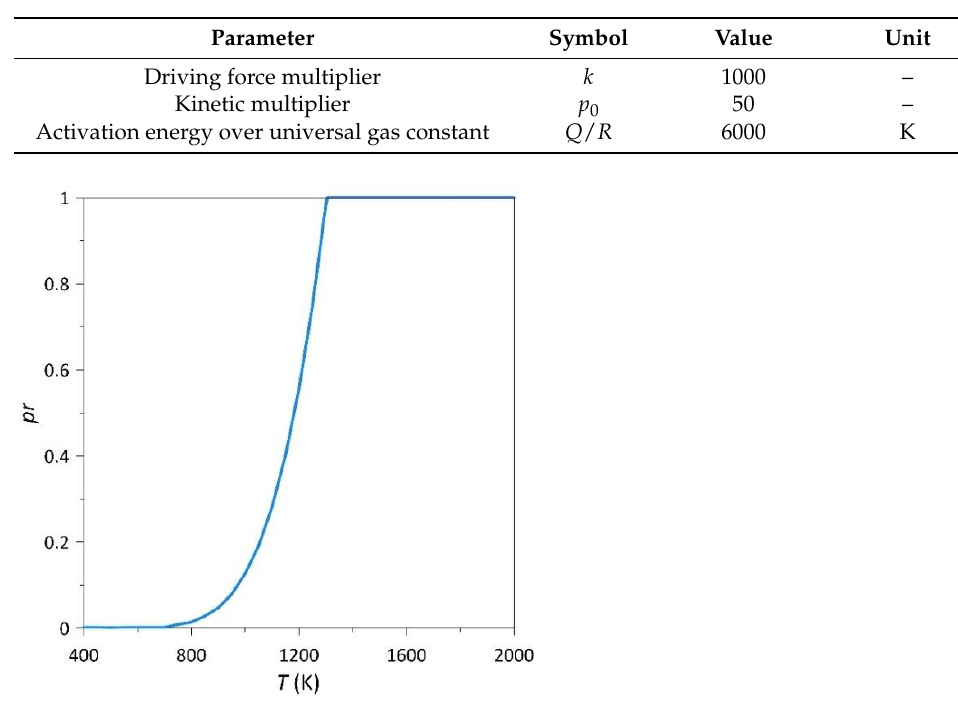
Table 1. Grain growth kinetic parameters.